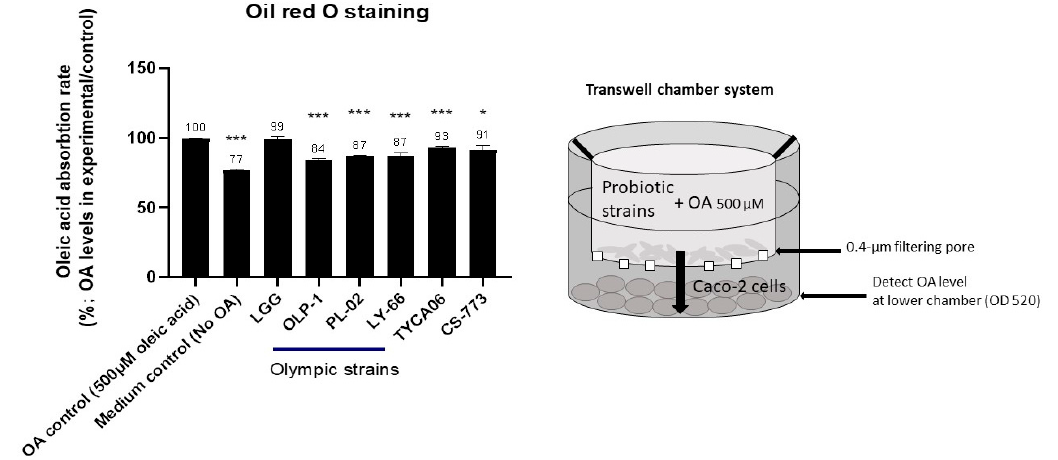
Figure 3. Probiotic strains absorbed fatty acids in vitro. In the experimental group, Caco-2 cells (2 × 10 6 ) were seeded to the lower chamber of a six-well transwell, while oleic acid (OA; 500 µ M) with probiotics (2 × 10 8 CFU/mL) was added to the upper chamber of the transwell (OA control: oleic acid without probiotic treatment; medium control: medium without oleic acid or probiotics). Probiotics, OA, and Caco-2 cells were cultured for 3 days, and OA levels in the lower chamber were detected with oil red O stain. OA absorption rate = OA levels in each probiotic group/OA control. * p < 0.05 and *** p < 0.001 compared with the OA control. All experiments were conducted in triplicate.